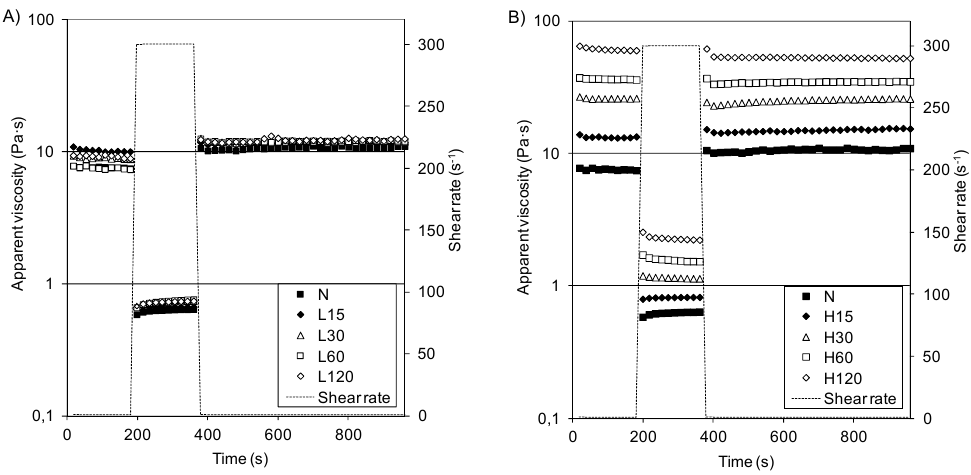
Figure 3. In-shear structural recovery curves of pastes of native starch and distarch phosphates: ( A ) L-starches, ( B ) H-starches. After the shear rate increase or decrease, all of the analyzed pastes quickly reached a stable viscosity. The recovery percentage of their structures is shown in Table 6. Starches N and L showed a recovery of 113–159%, which indicates a different starch paste structure. The H-starches were more resistant to the mechanical influences; however, their recovery times (R = −